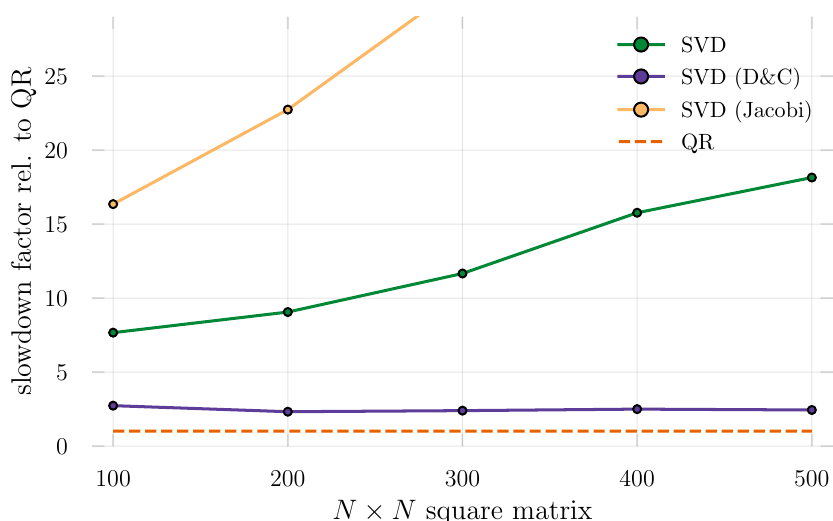
Figure (3) Computational efficiency of matrix decompositions . Shown is the runtime cost of the factorization of a complex matrix of size N × N by means of various SVD algorithms relative to the QR